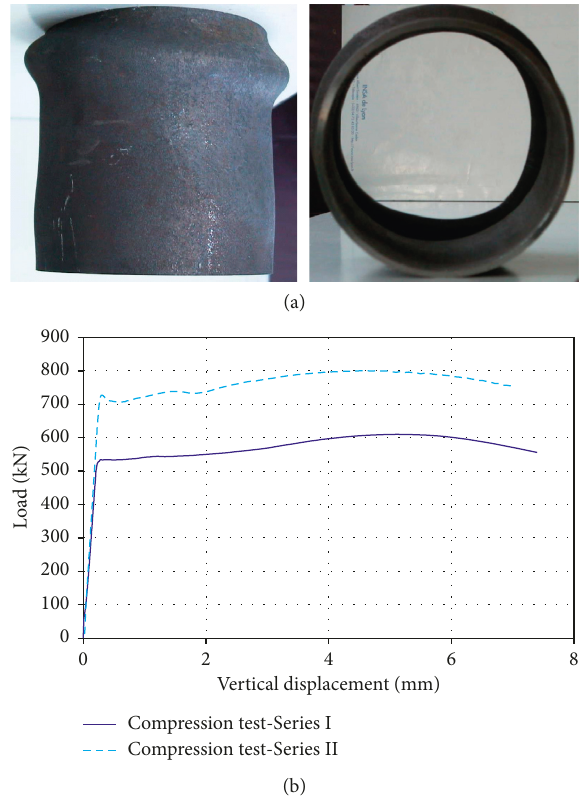
Figure 5: Unstrengthened shell: (a) extensional axisymmetric mode ( n 0); (b) load/displacement (cid:31)